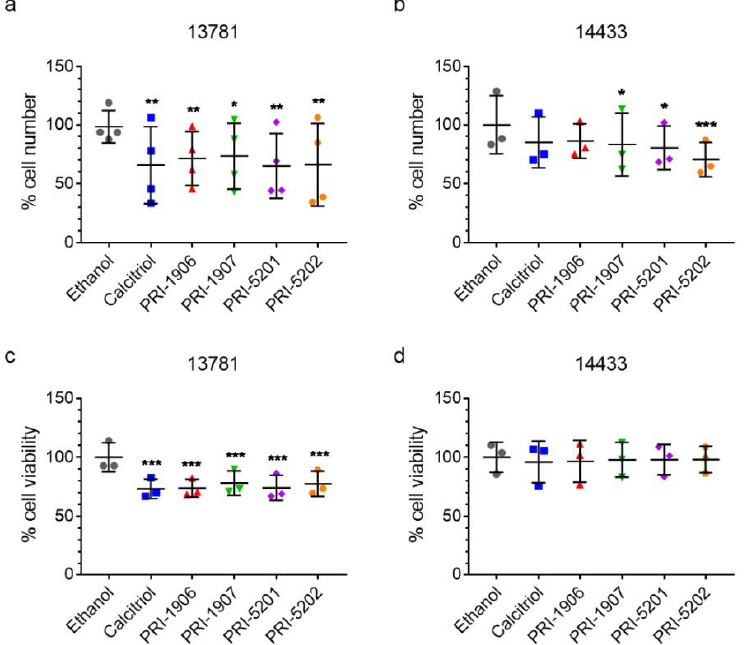
Figure 7. Cell number and viability in ( a , c ) 13781, and ( b , d ) 14433 cells after treatment with an1,25Ds at a concentration of 100 nmol/L for 5 days. RM-ANOVA with Dunnett post-test vs. ethanol control, * p < 0.05, ** p < 0.01, *** p < 0.01, N = 4 ( a ), 3 ( b – d ).